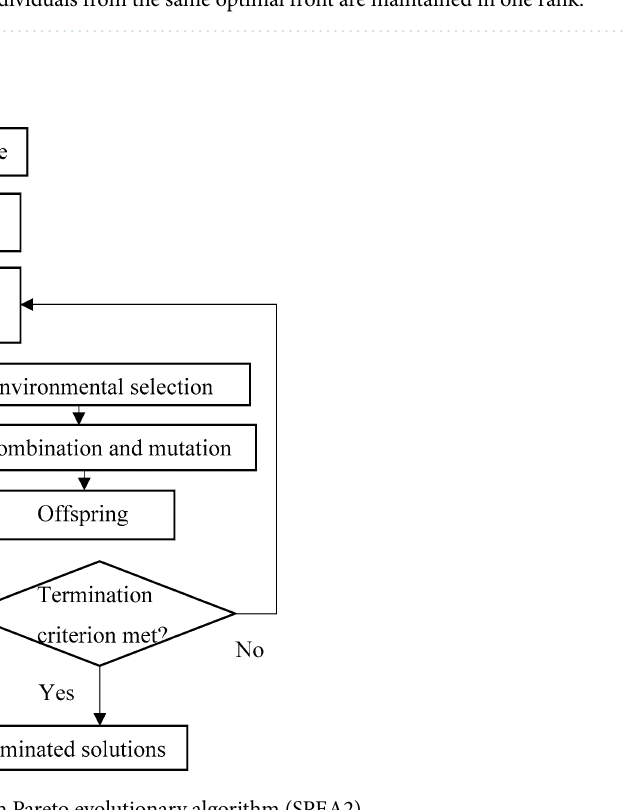
Figure 16. Flowchart of strength Pareto evolutionary algorithm